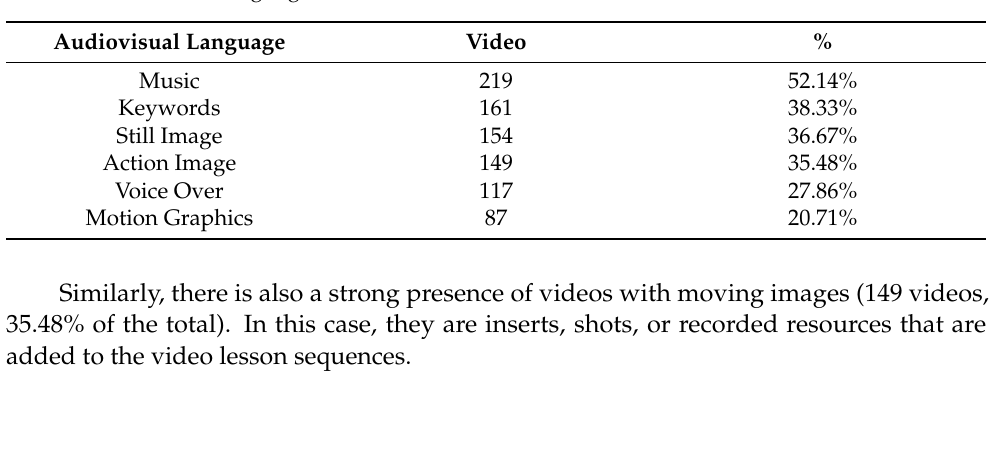
Table 3. Audiovisual language